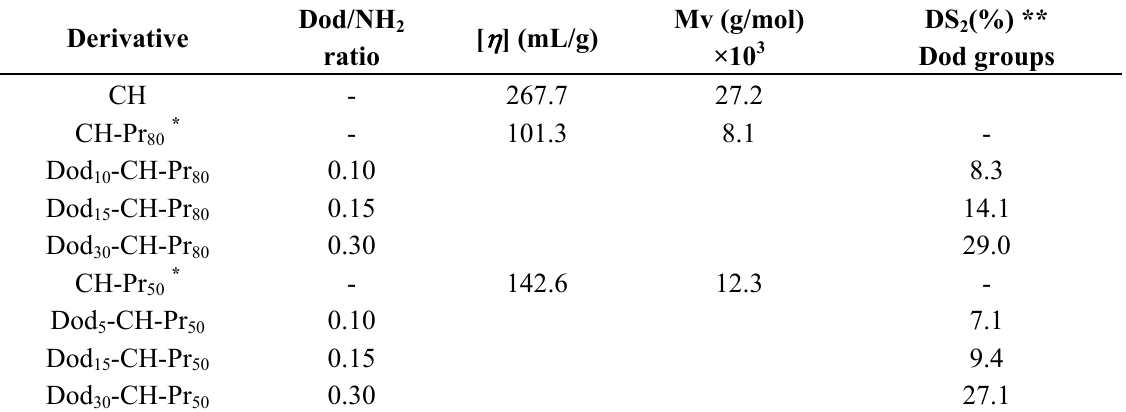
Table 1. Properties of chitosan and its amphiphilic derivatives used for antifungal